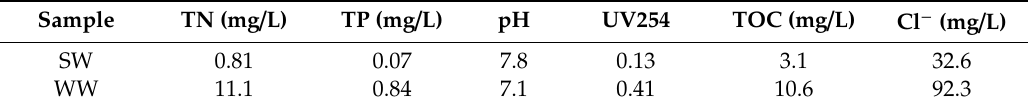
Table 1. Characteristics of water samples.